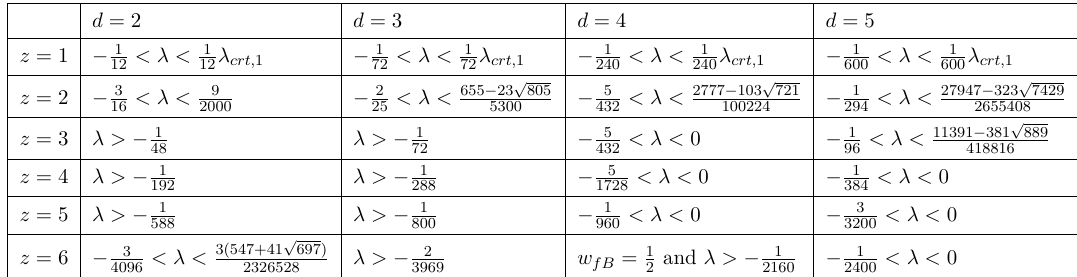
Table 4 . The appropriate ranges of the coupling constant λ for which w fB is a maximum inside the horizon. Here, λ is defined by eq. crt, 1